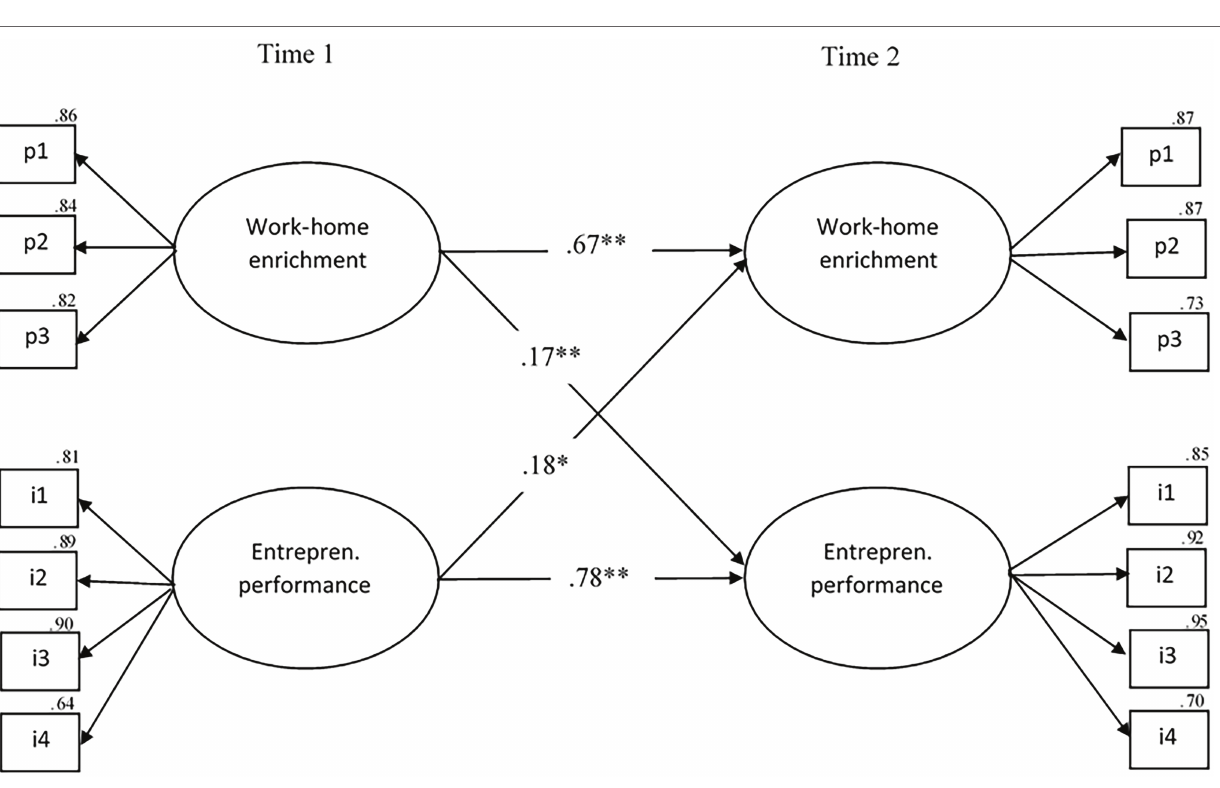
FIGURE 4 | The final model of the statistically significant cross-lagged relationships between work–home enrichment and entrepreneurial performance. N = 249, * p < 0.01, ** p < 0.001, pl−p3 parcels 1 through 3, i1–i4 = items 1 through 4. entrepren =